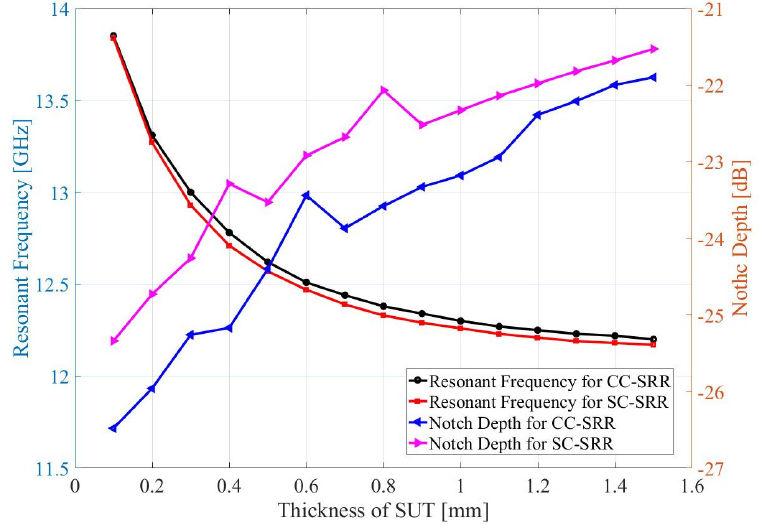
Figure 5. The sensor’s ground plane contains the sample under test (SUT) which interacts with the electromagnetic fields created by the microstrip transmission line and radiated by the resonator, ( a ) Top View ( b ) Front View.